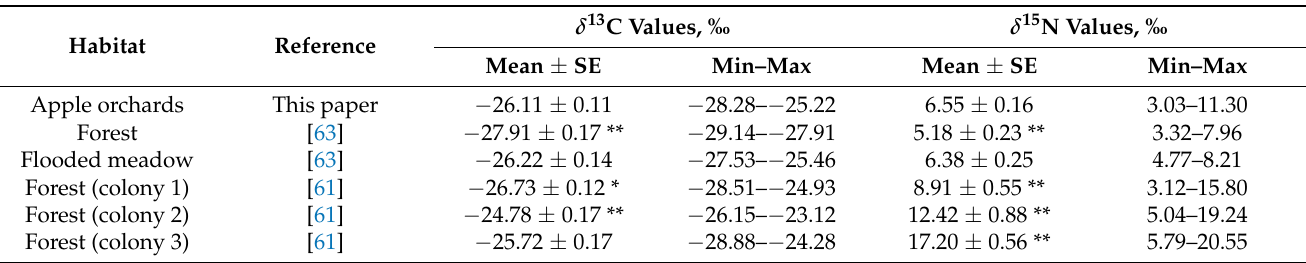
Table 3. Central positions and ranges of stable isotope values in the hair of C. glareolus in various habitats of Lithuania. Great cormorant colonies 1, 2 and 3 are characterised with increasing numbers of breeding bird pairs, therefore, higher input of guano. Significance of differences from apple orchards: *— p < 0.01, **— p <